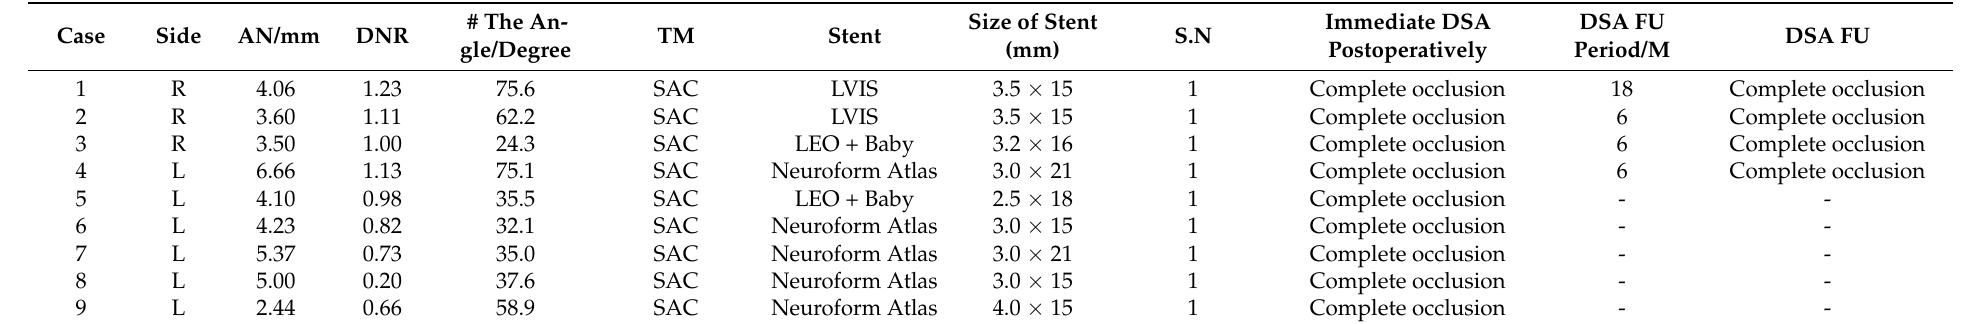
Table 2. Aneurysmal